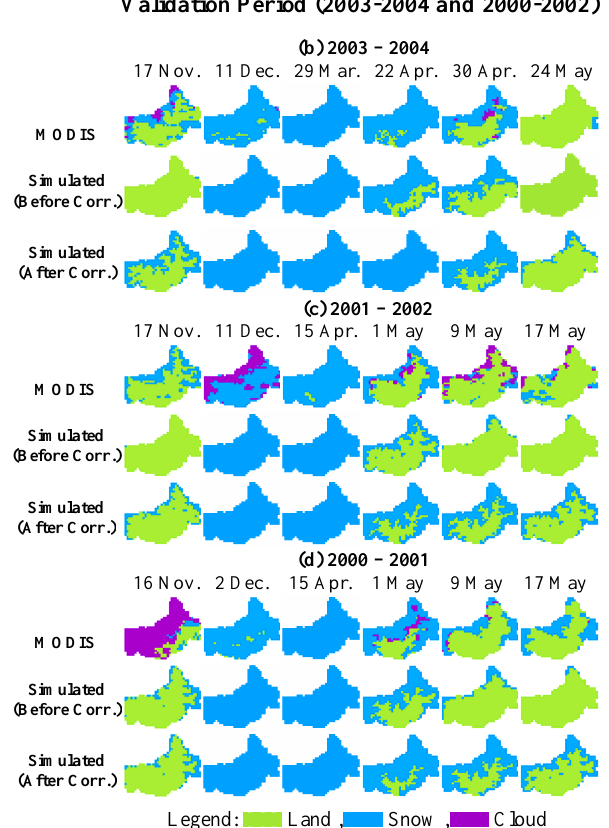
Fig. 6. Comparison of simulated spatial distribution of snow cover with MODIS snow cover pixels, in calibration (2003) and validation (2004, 2002 and 2001) periods, for simulations with and without correction for snowfall.